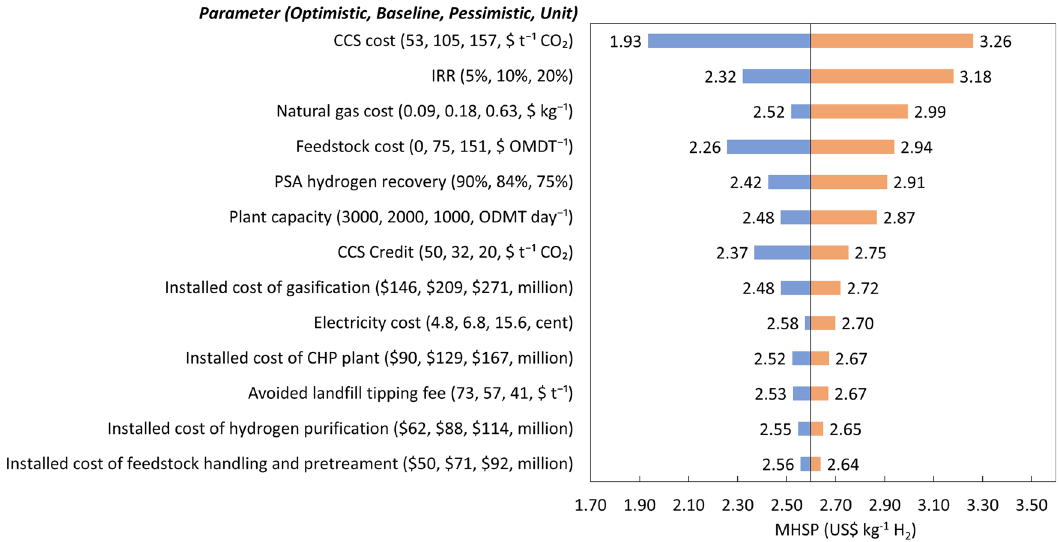
Fig. 4 Sensitivity analysis of Scenario 3-MPW at 2000 oven-dry metric tons per day. The blue bars indicate the optimistic results of MHSP due to parameter uncertainty, while the orange bars show pessimistic